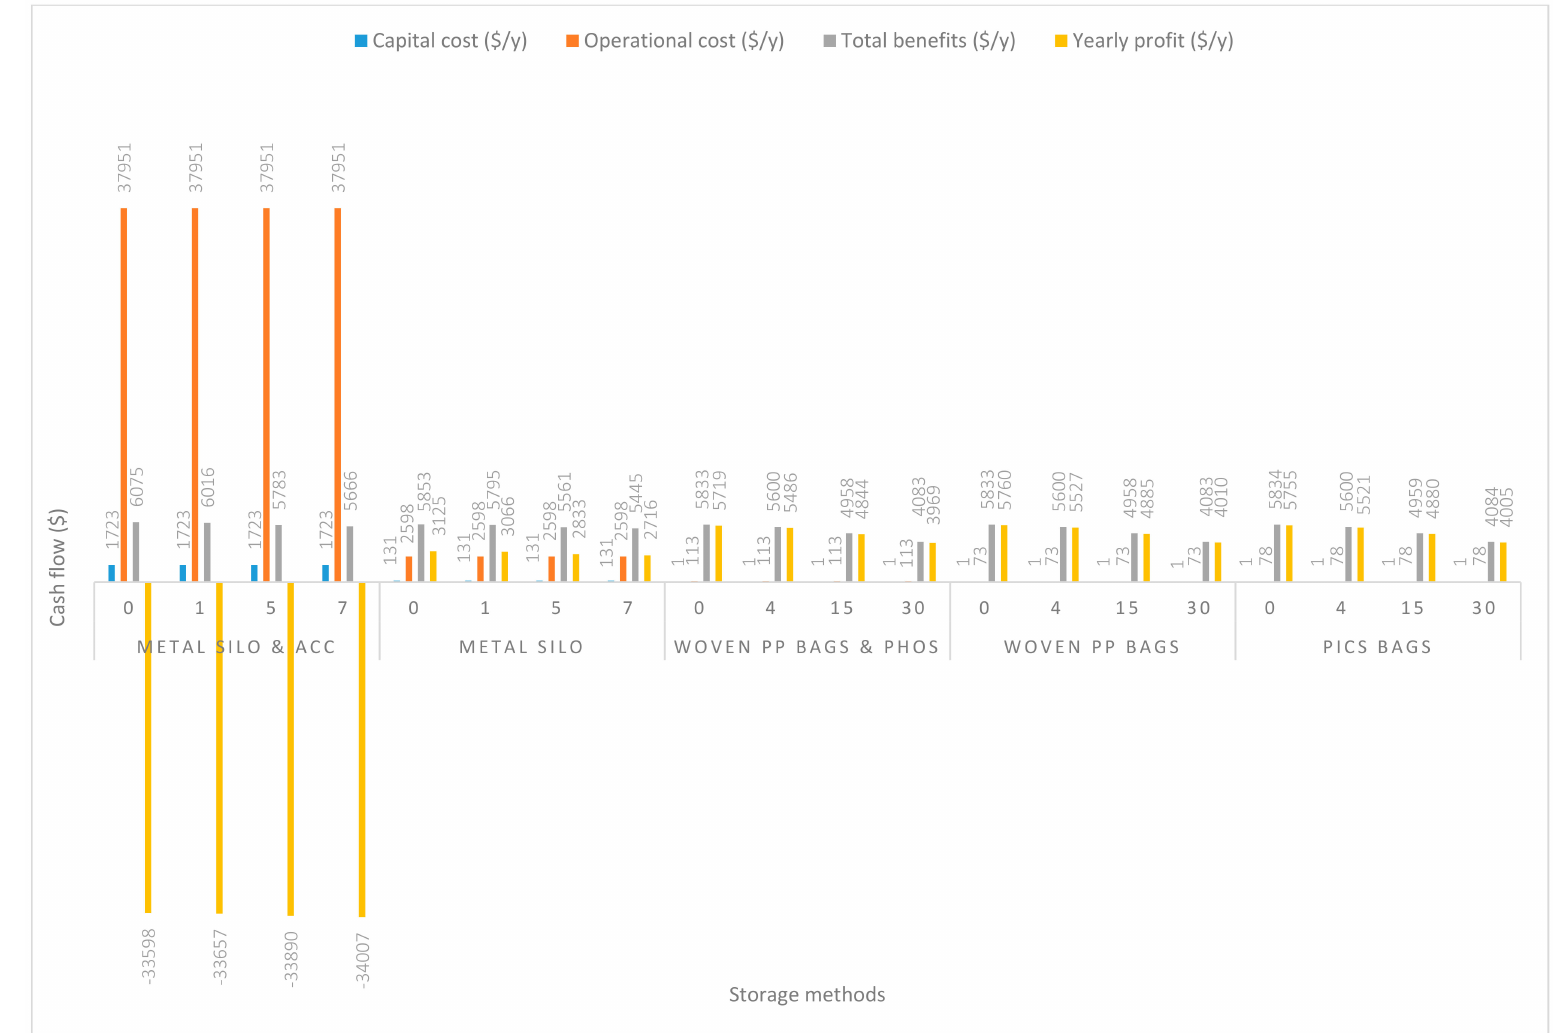
Figure 7. Annual capital and operational costs (US dollars), total annual benefits and profits (US dollars) for each handling / storage method at 28 Mg / y handling capacity for 0% to 7%, and 0% to 30% grain quantity